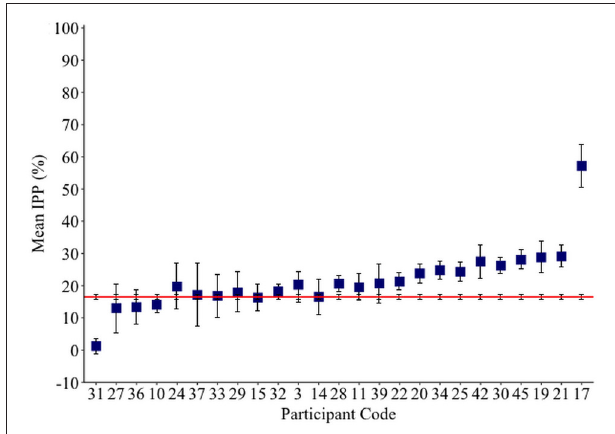
FIGURE 3 | Mean Intrusion Perseveration Probability (IPP) score per Jargon individual (square), and IPP chance estimate (red line). Error bars show 95% confidence intervals.